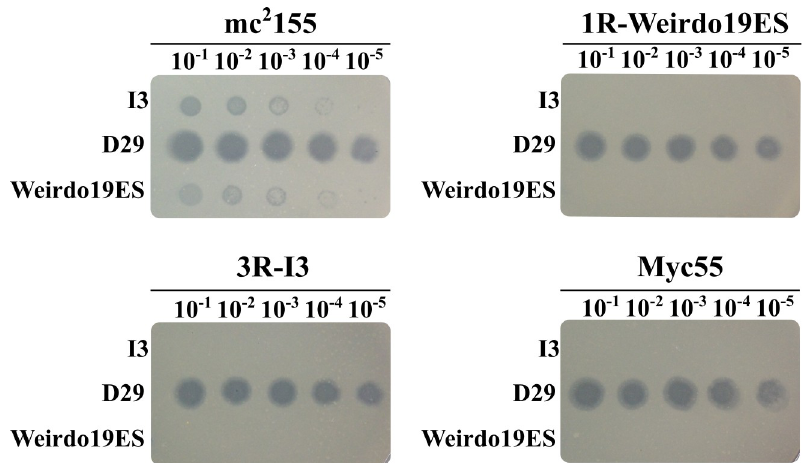
Fig 10. Cross-resistance of mutants 1R-Weirdo19ES, 3R-I3 and Myc55 to mycobacteriophages Weirdo19ES and I3. Aliquots (5 μ l) of ten-fold dilutions of Weirdo19ES, I3 or D29 (used as control) were spotted on Indicator Plates containing either the wild-type strain, 1R-19WeirdoES, 3R-I3 or Myc 55 on solid medium. Lysis was determined after 24–48 h of incubation at 30˚C. https://doi.org/10.1371/journal.pone.0231881.g010 Chen and co-workers isolated M . smegmatis I3 resistant mutants which upon analysis showed insertions in four genes [43]. We selected one of them, MSMEG_0392, encoding the